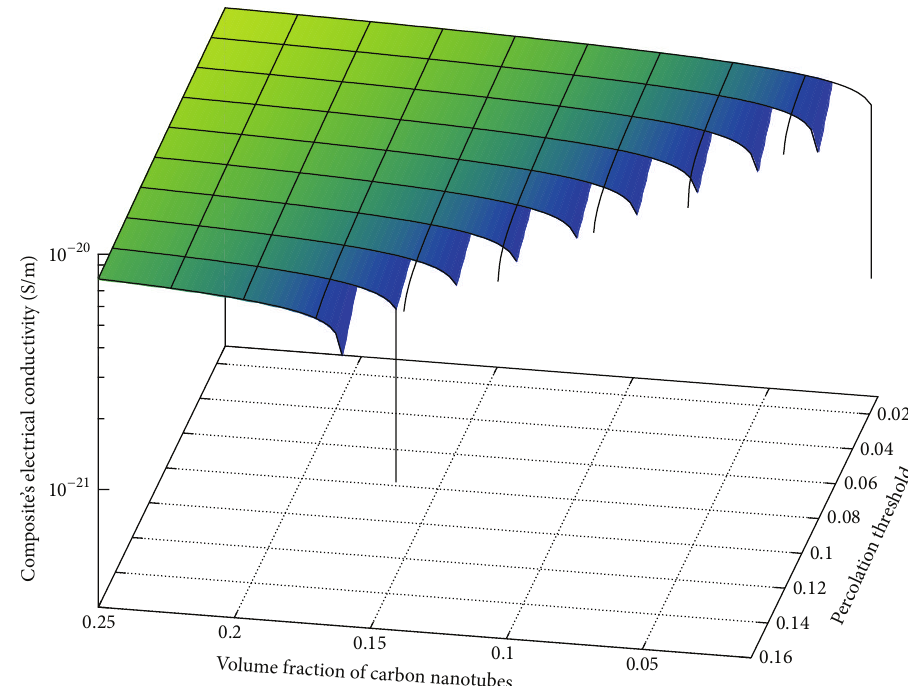
Figure 9: DC electrical conductivity of the nanocomposite at varying both the percolation threshold of the filler and the volume fraction of the filler (Kirkpatrick’s model).